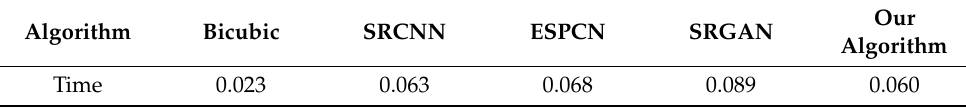
Table 3. Comparison of the running time of each algorithm.